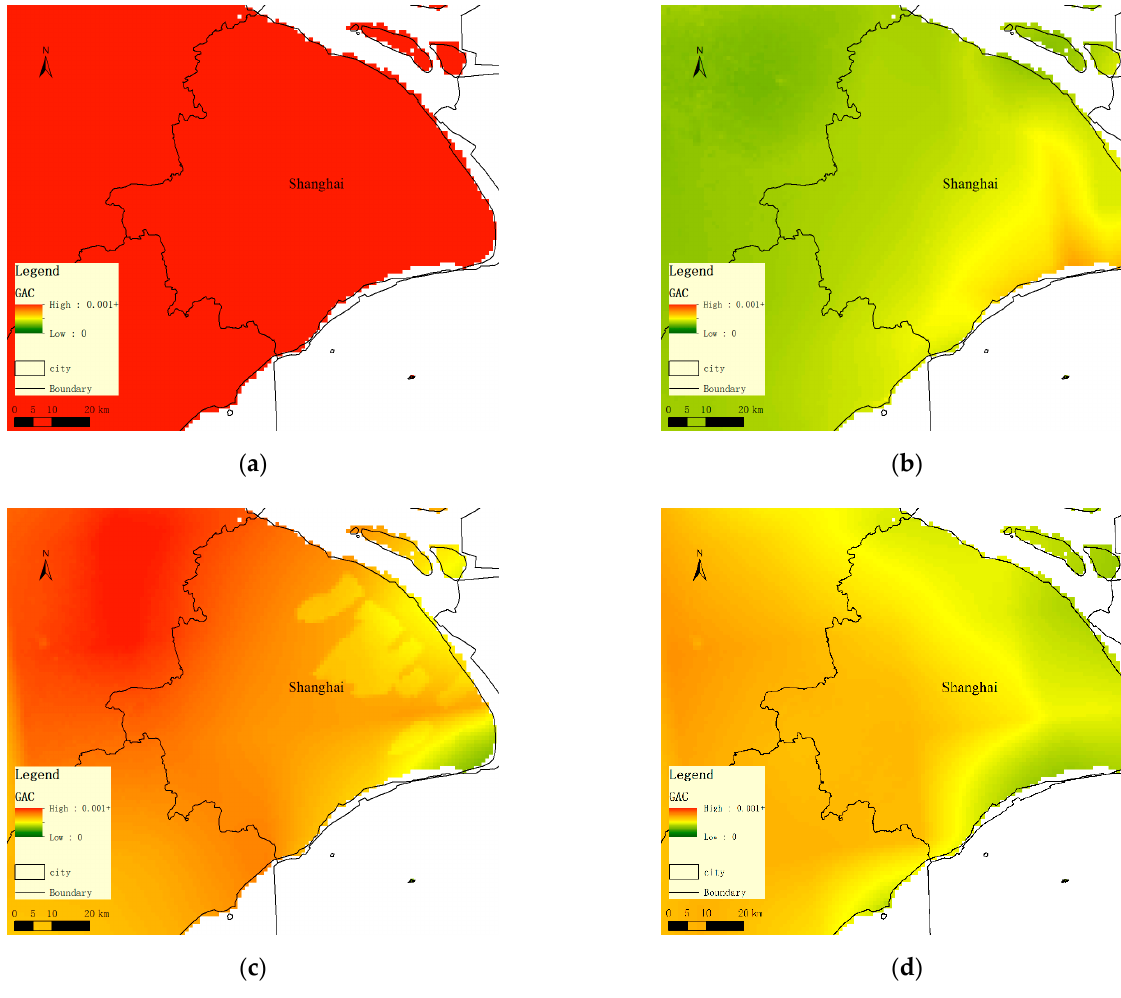
Figure 15. Spatial distributions of GAC (m − 1 ) for four seasonal days in Shanghai: a spring day (1 April 2015) ( a ), a summer day (1 July 2016) ( b ), an autumn day (1 October 2017) ( c ) and a winter day (30 December 2018) ( d ).